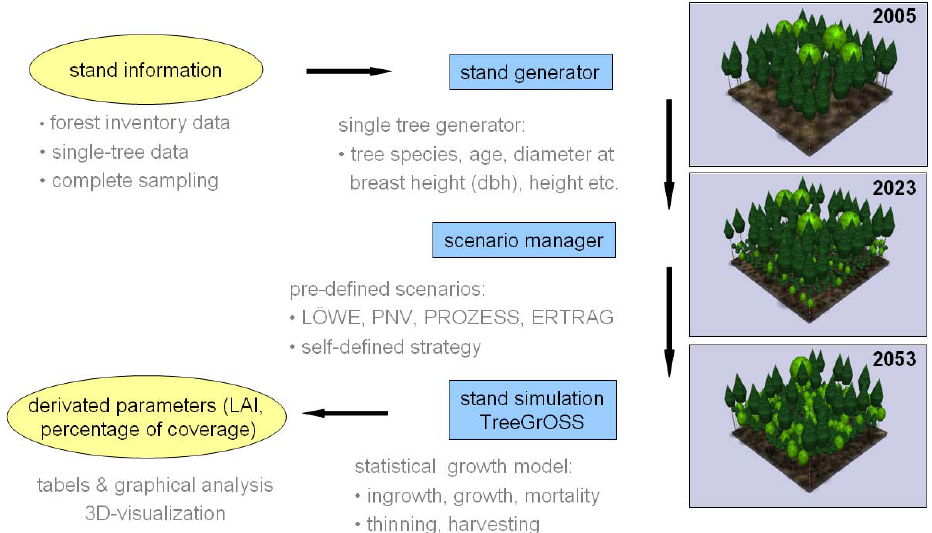
Fig. 2. Stand simulation of a European beech Norway spruce mixed stand with